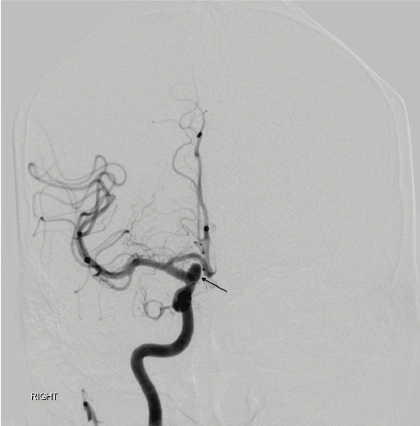
Figure 6: Anterior-posterior view of right carotid angiogram dem- onstrating paraophthalmic ICA aneurysm (arrow).